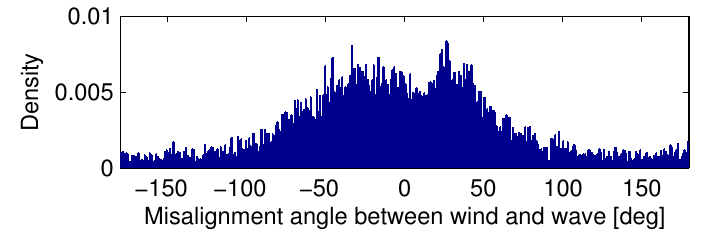
Figure 1. Probability density function of wave misalignment at the Hywind location, sampled primary during the first five months of